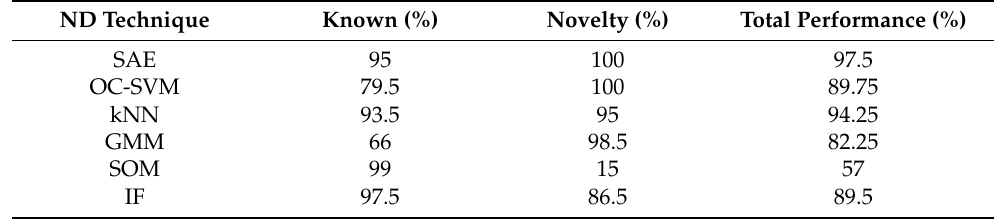
Table 7. Numerical results of the novelty detection obtained for the third case study of the SPG_DS.